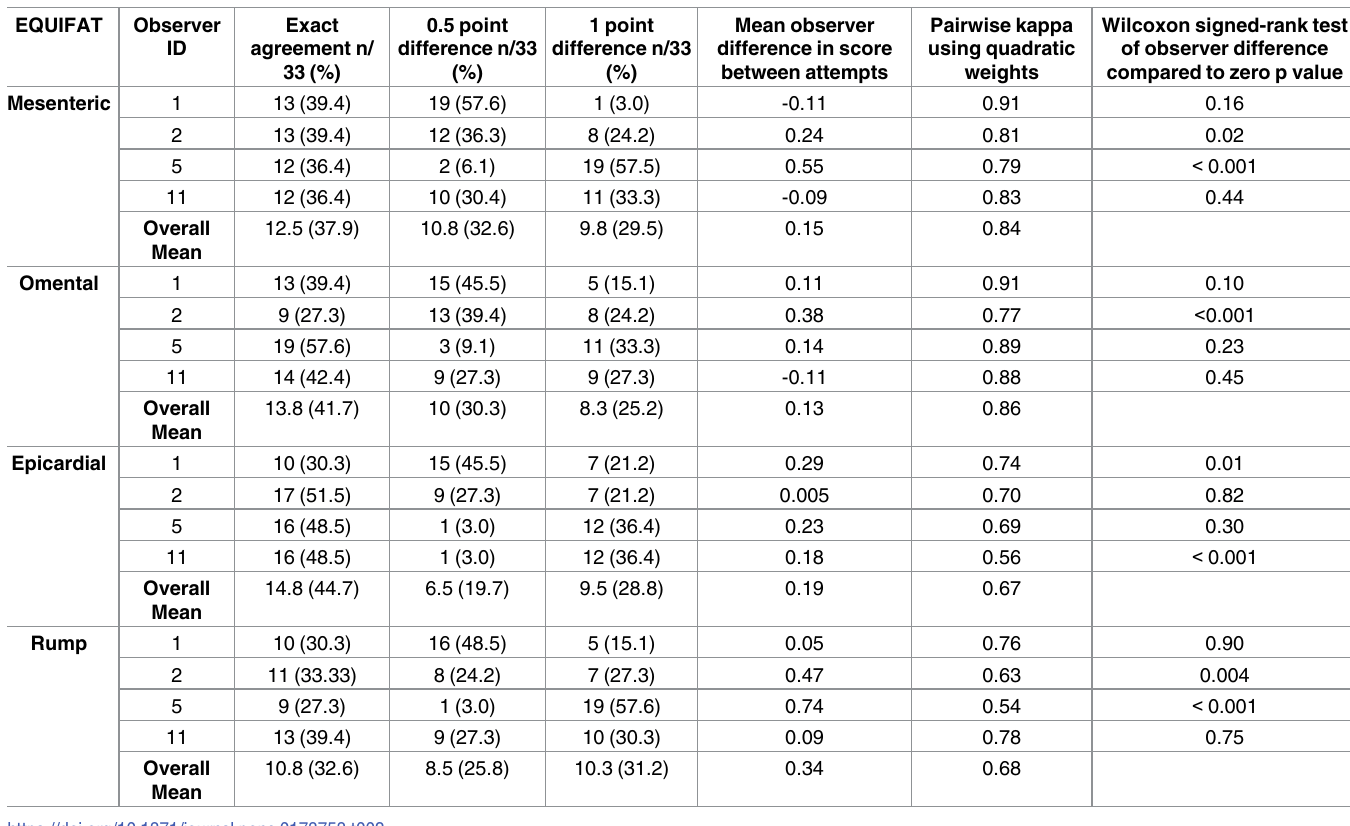
Table 2. Intra-observer repeatability of the EQUIFAT scores for the four observers using half scores and assessing 33 images each of 4 adipose depots. A minimum of 14 days lapsed betweenattempts. Agreement data are presentedfor exact, 0.5 and 1 point differencesbetweenattempts. Kappa tests and p values for Wilcoxon sign-ranktest are